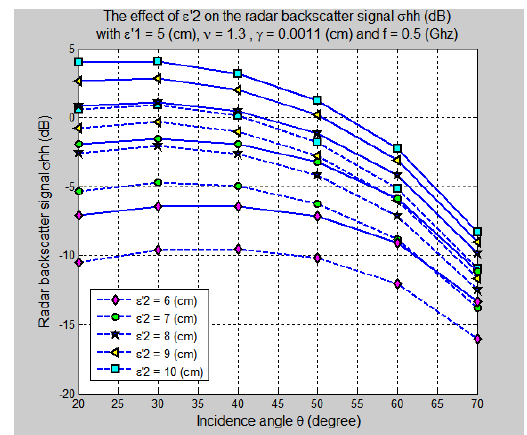
Figure 10: Backscattering coefficient dependence on ε 2′ at VV polarization for bare soil (dashed line) and for vegetated soil (full line)